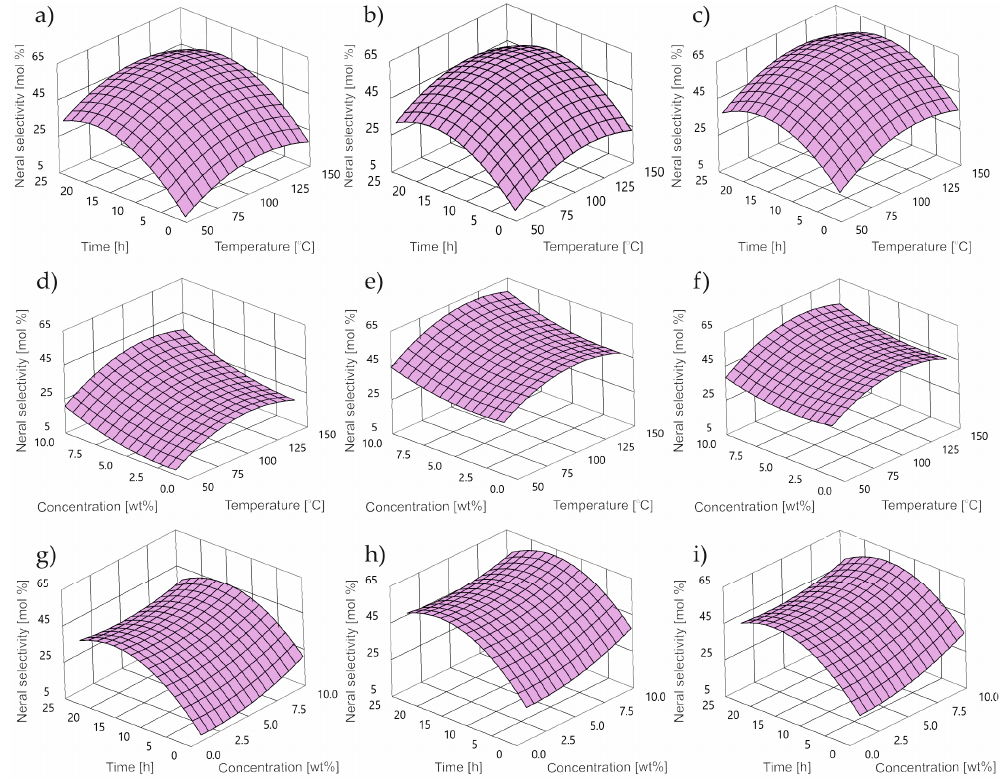
Figure 6. Contour plot of dimethyl selectivity at: concentration ( a ) 1 wt%; ( b ) 5 wt%; ( c ) 10 wt%;